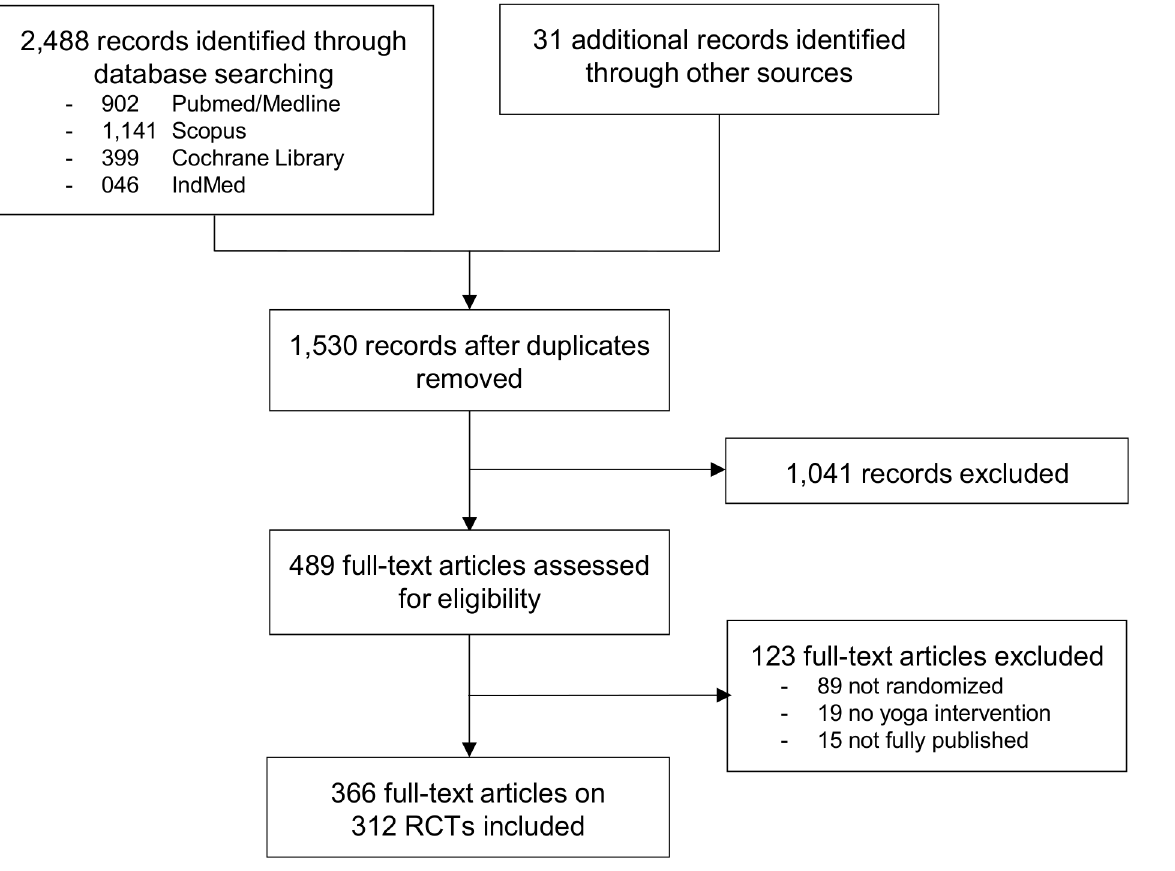
Fig 1. Results of the literature search.